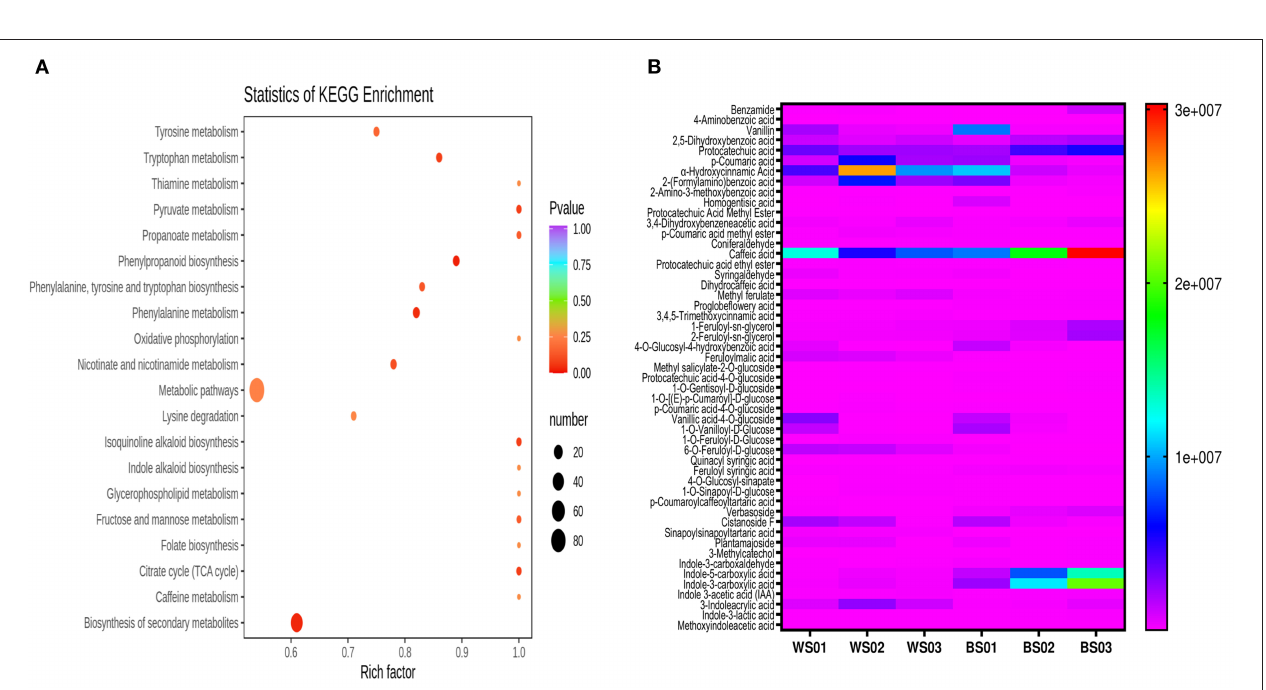
FIGURE 6 | Differential metabolites between NaOH and 70 % methanol extracts of sesame seeds. (A) Venn diagram exhibiting the number of the key metabolites that exhibited high relative content in NaOH extract; (B) Classification of the 72 key metabolites that were more soluble in alkaline solution. The definition of labels is presented in Supplementary Table S1 .